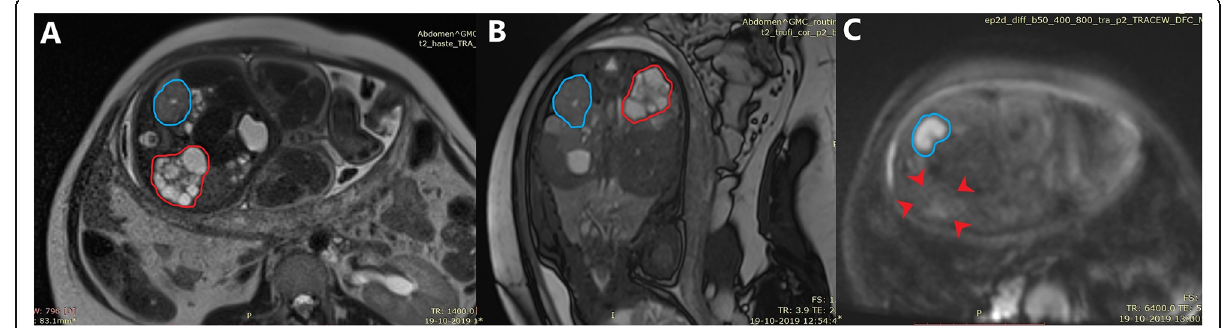
Fig. 1 Right-sided multicystic dysplastic kidney disease: maternal age: 25 years; period of gestation: 38 weeks 1 day; T2 HASTE axial ( a ) and T2 TRUFI coronal ( b ): Left kidney is normal (blue tracing) while right kidney (red tracing) displays lobulated contour with multiple, variable-sized, non-communicating and clustered internal cysts. DWI axial ( c ) shows a low signal in the right kidney (arrowheads) with normal bright signal in left